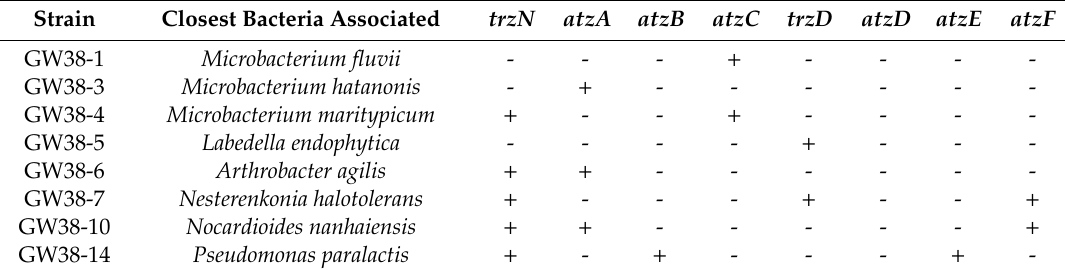
Figure 2. Atrazine degradation pathway. Each reaction shows the genes screened and the name of the corresponding enzyme responsible for catalyzing the reaction. corresponding enzyme responsible for catalyzing the reaction Table 4. Atrazine degrading genes present in isolated bacteria. + : positive amplification signal; -: no Table 4. Atrazine degrading genes present in isolated bacteria. +: positive amplification signal; -: no amplification amplification signal.